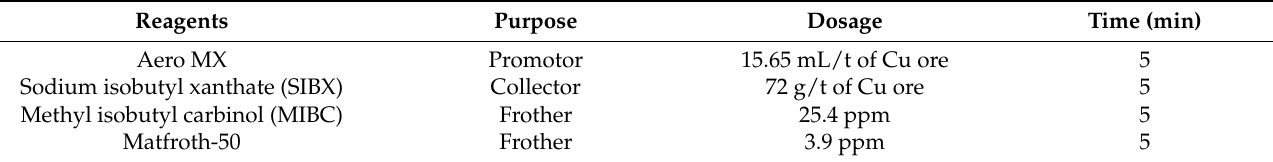
Table 2. Reagents and conditioning time used during